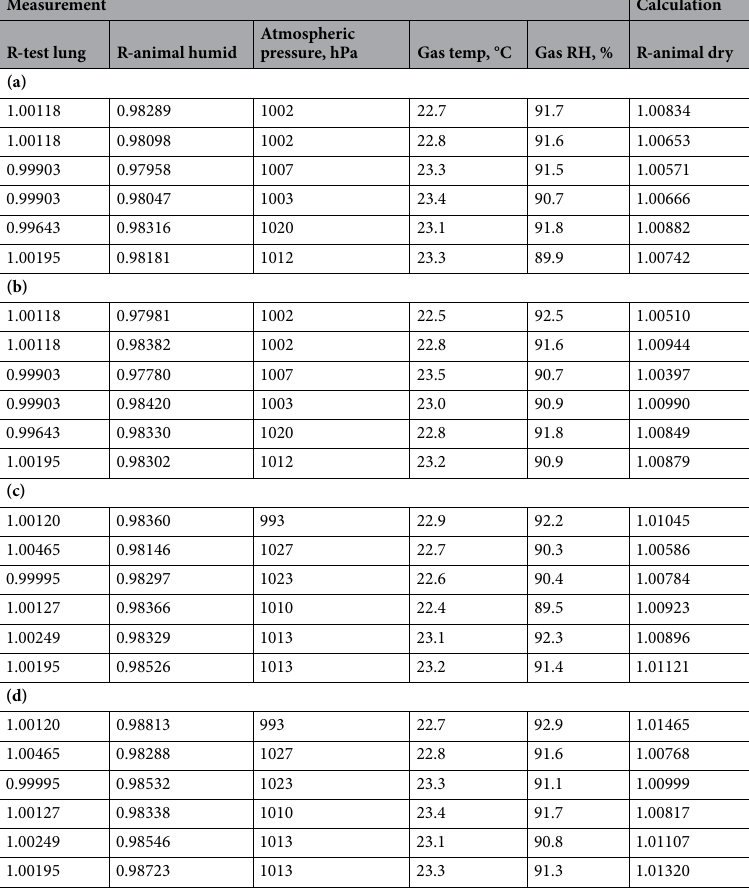
Table 1. (a) Midazolam/Fentanyl at FIO2 0.3, (b) Midazolam/Fentanyl at FIO2 1.0, (c) Isoflurane at FIO2 0.3, (d) Isoflurane at FIO2 1.0.